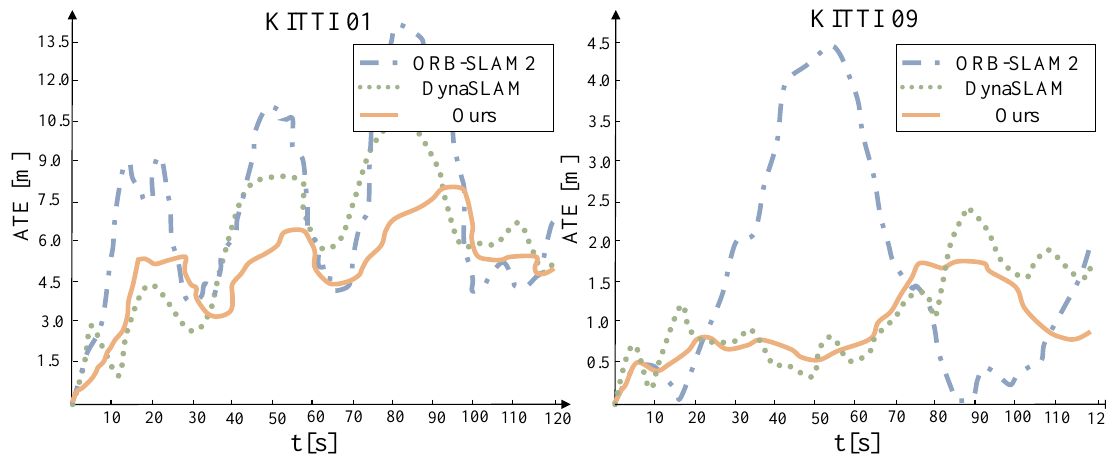
Figure 9. Comparison of camera translation trajectory errors in high-dynamic sequence.